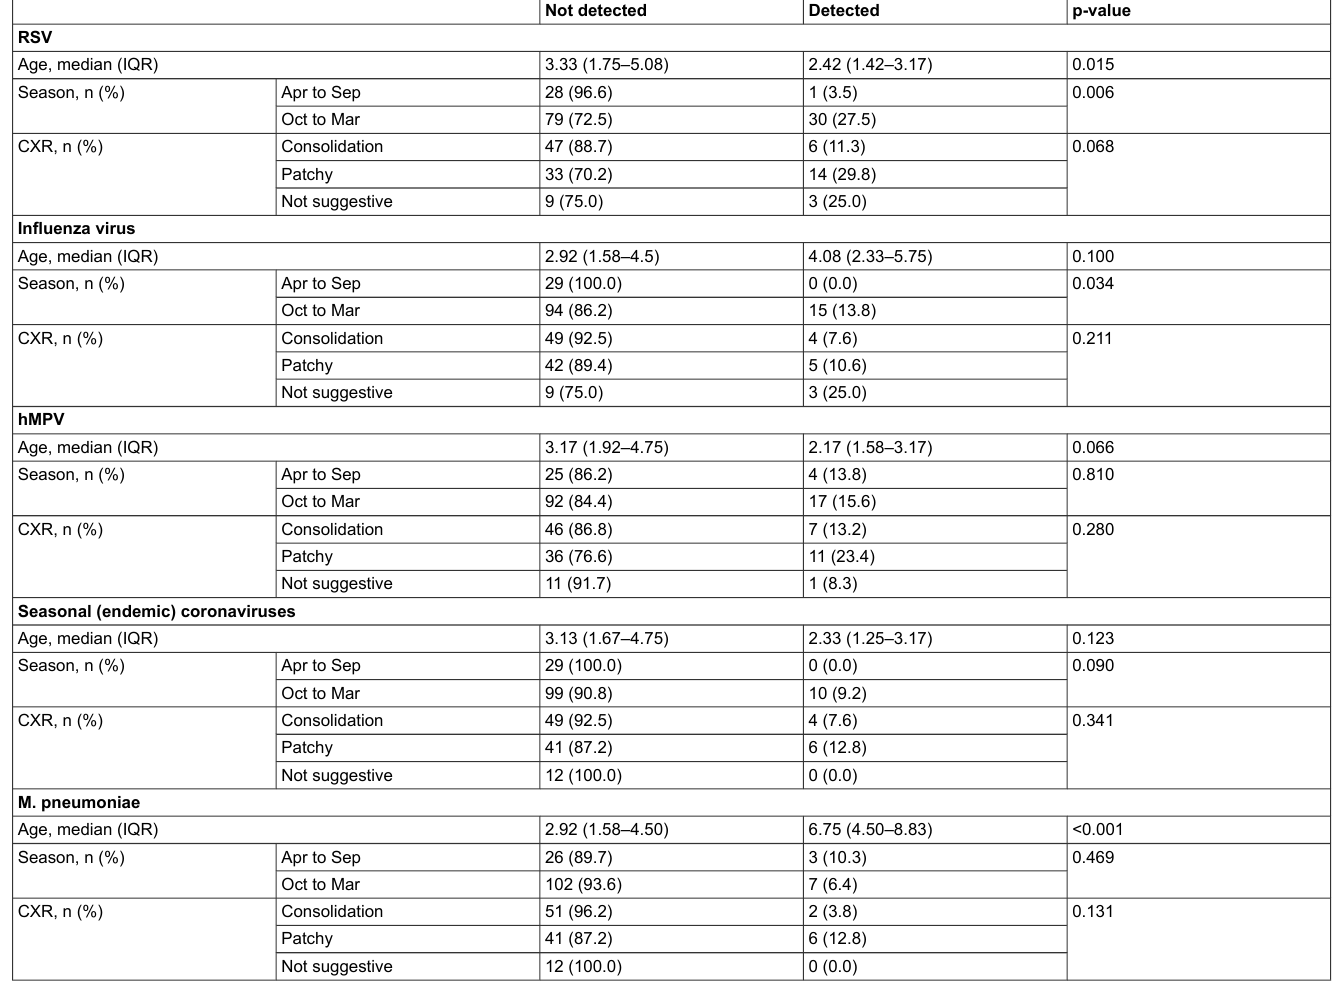
Table 4: Age, season and chest X-ray findings by detection of respiratory pathogens.